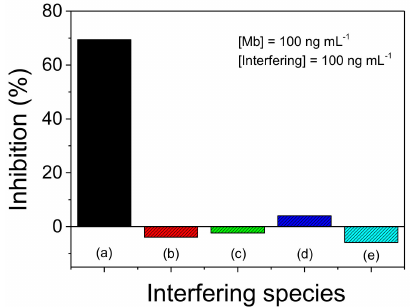
Figure 6. Percentage of inhibition of the anti-Mb/CdSeS/ZnSQDs/BTO/FTO immunosensor in: (a) Mb; (b) Mb + BSA; (c) Mb + HSA; (d) Mb + Troponin; (e) Mb + Cytochrome C. Measure- ments performed in 0.10 mol L − 1 phosphate buffer solution, pH 7.4, containing 0.25 mol L − 1 of VC, under applied potential of 0 V and incubation time of 0.67